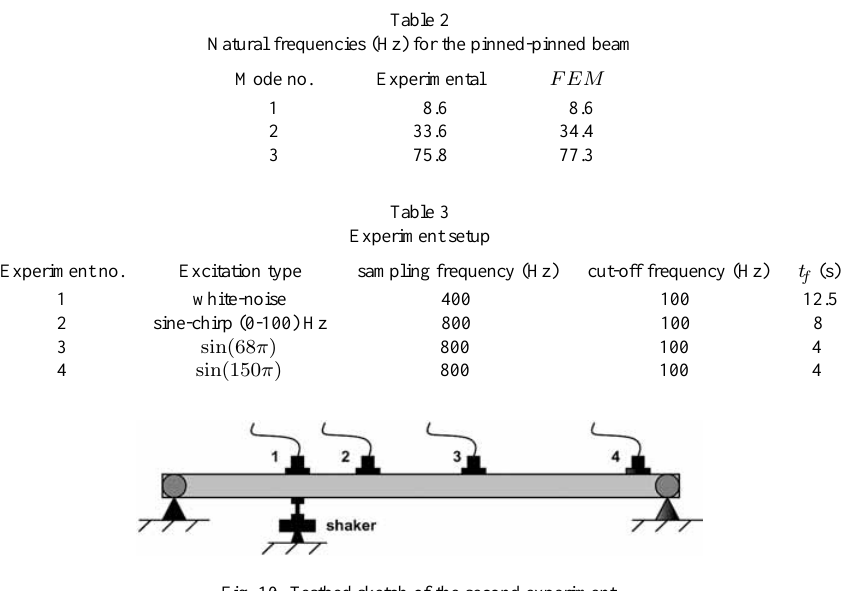
Fig. 10. Testbed sketch of the second experiment.